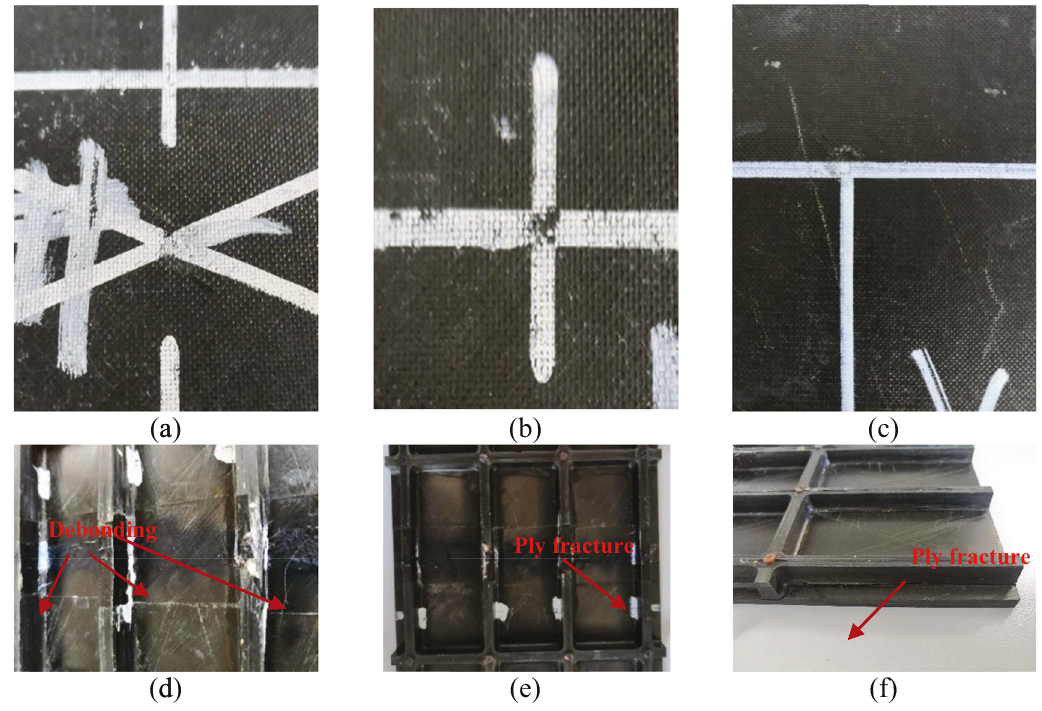
Figure 6: ( a and d ) External damage of #6 specimen; ( b and e ) external damage of #7 specimen; and ( c and f ) external damage of #8